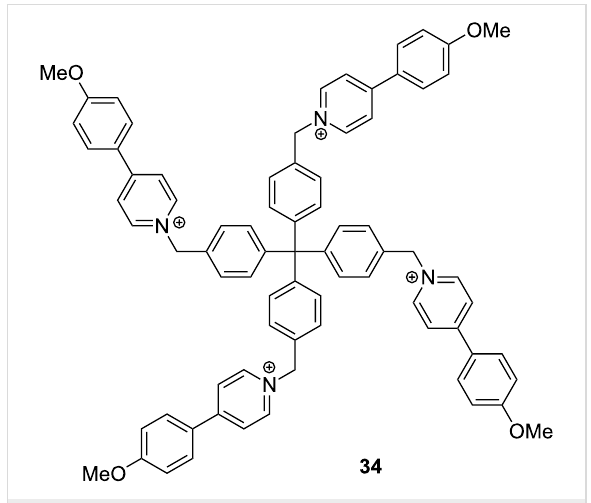
Scheme 18: The structure of compound 34